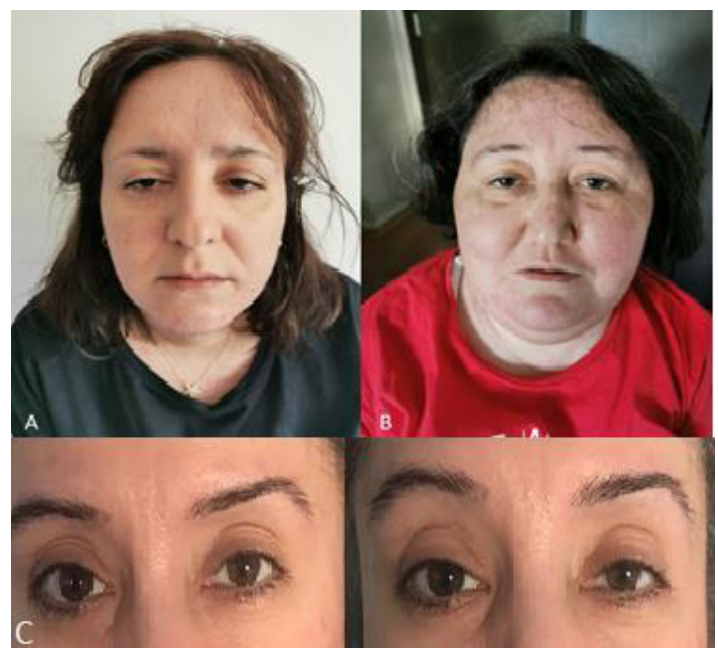
Figure 2. ( A ) Patient B showing ptosis and facial weakness at age 39 years old; ( B ) Patient A showing ptosis and facial weakness at age 38 years old; ( C ) Patient D with fatigable ptosis.